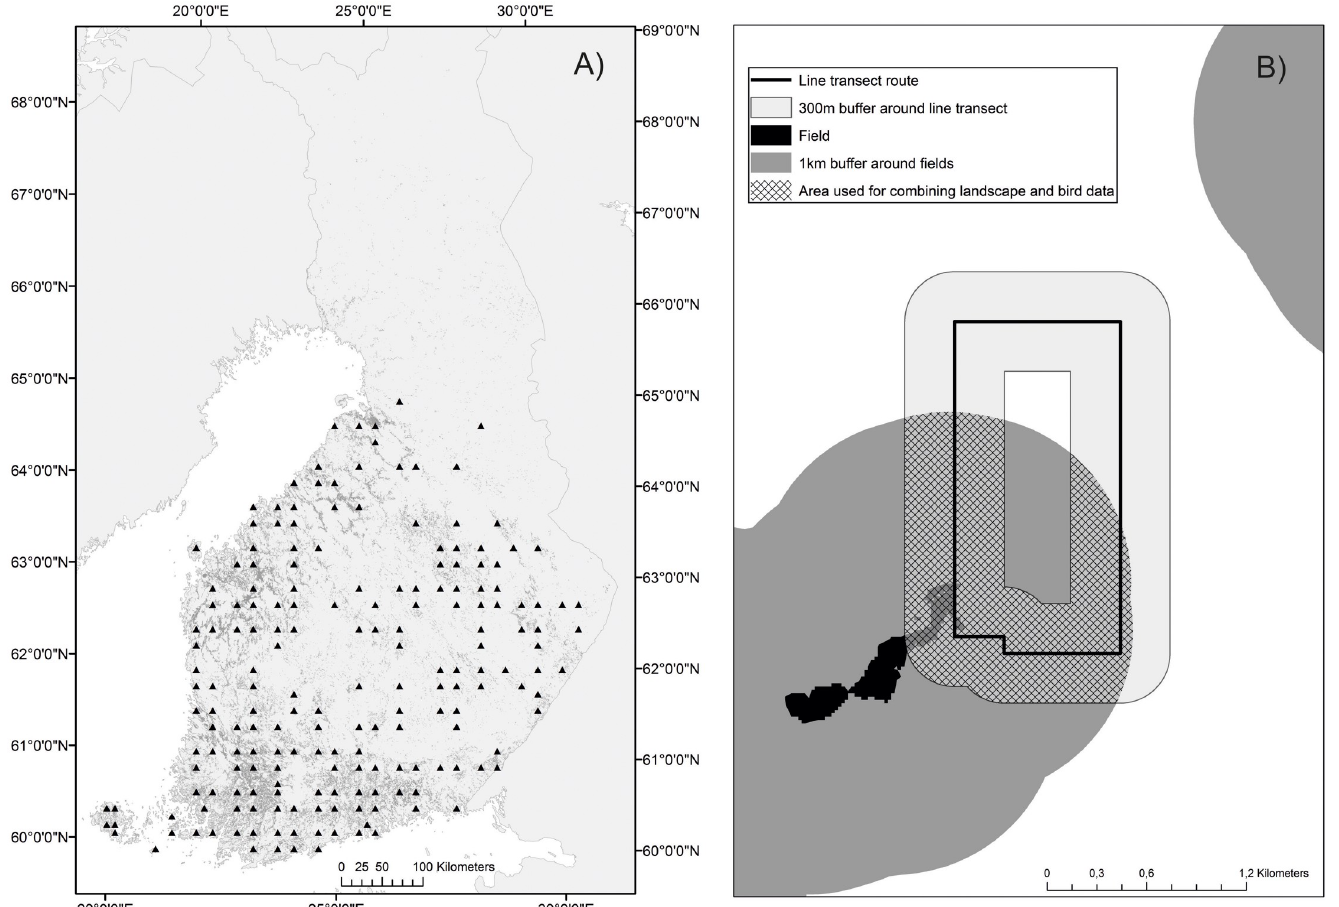
Fig 1. Study system and approach for combining data. A) The distribution of the line transects (black triangles) used for this study across the study region in South and Central Finland. B) An example showing how the landscape data where combined in space with the bird observation data from the line transects. The figure shows in dark grey the area within 1km from a field within which the landscape variables, centered at each farm, were interpolated. This area was in turn intersected with the 300m buffer zone (light gray area in panel A), and with the 1km buffer zone (not shown for simplicity) around a transect line (black continuous line). The average pixel value of the interpolated landscape variable (i.e. the relative influence of each land-use or Agri-environment scheme) within the intersection area (shown with hash pattern) was then extracted and related to the bird observations from that transect line.